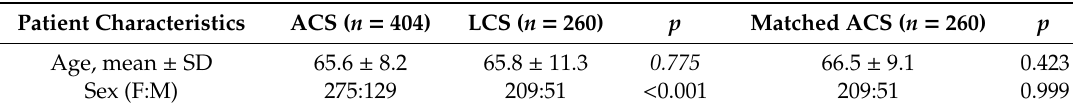
Table 1. Characteristics of the study population. ACS patients were matched to LCS patients for age and sex.